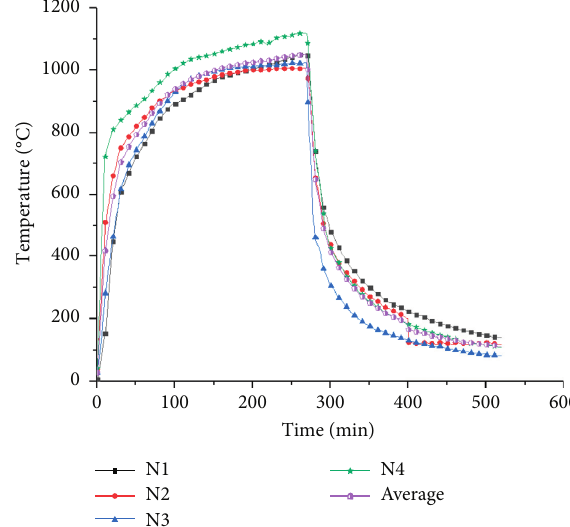
Figure 12: Recorded temperature-time